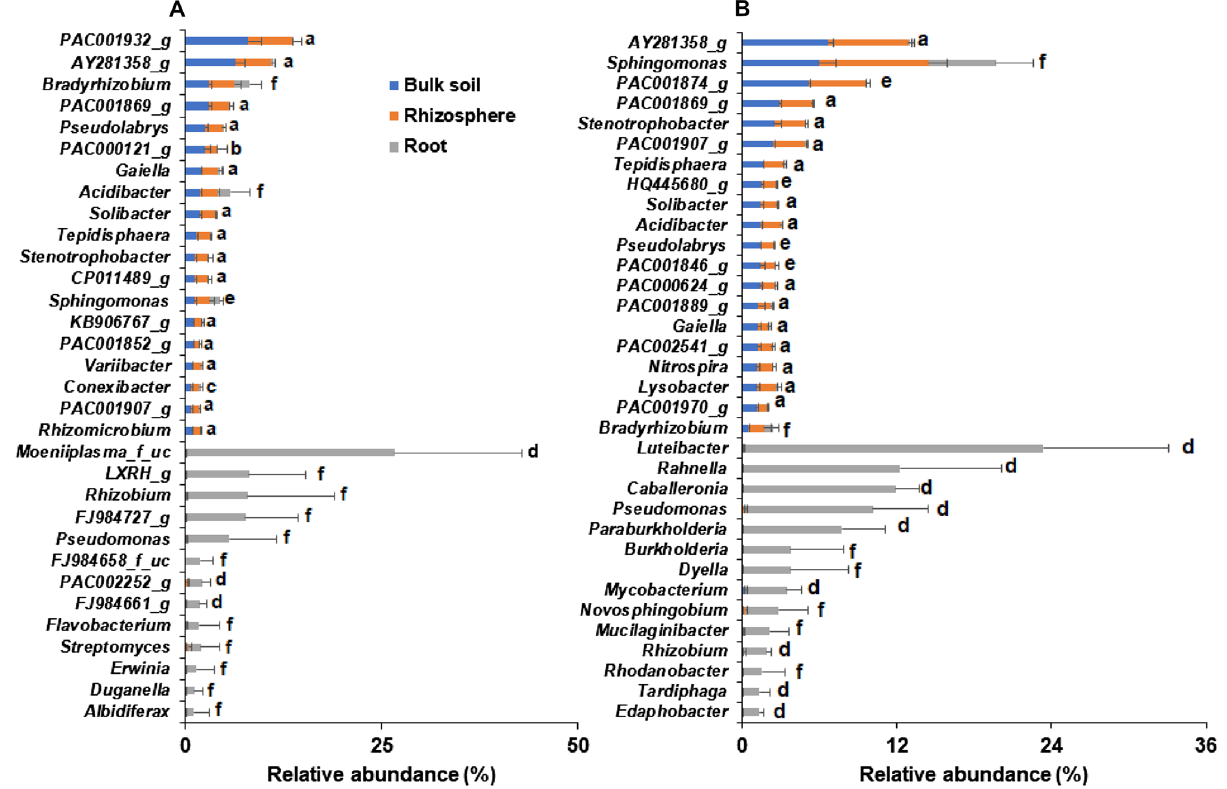
Figure 4. Comparison of relative abundance of bacteria at the genus level in bulk soil, rhizosphere, and root of Ulleung-sanmaneul plants. The bacterial genera with at least 1% relative abundance in each compartment of wild ( A ) and cultivated ( B ) habitats were selected for comparison. Data represent mean ± SD and letters in bars present significant difference at P = 0.05 as follows: (a) Bs = Rs > Ro, (b) Bs = Rs ≥ Ro, (c) Rs = Bs ≥ Ro, (d) Ro > Bs = Rs, (e) Bs > Rs > Ro and (f) Bs = Rs =